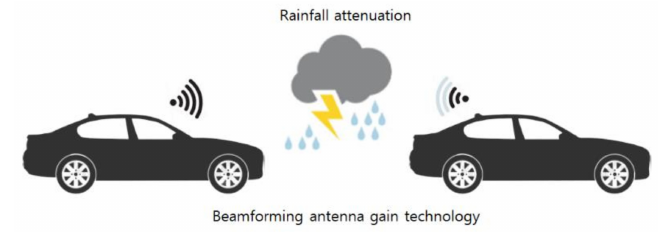
Figure 2. Need for improvement of system